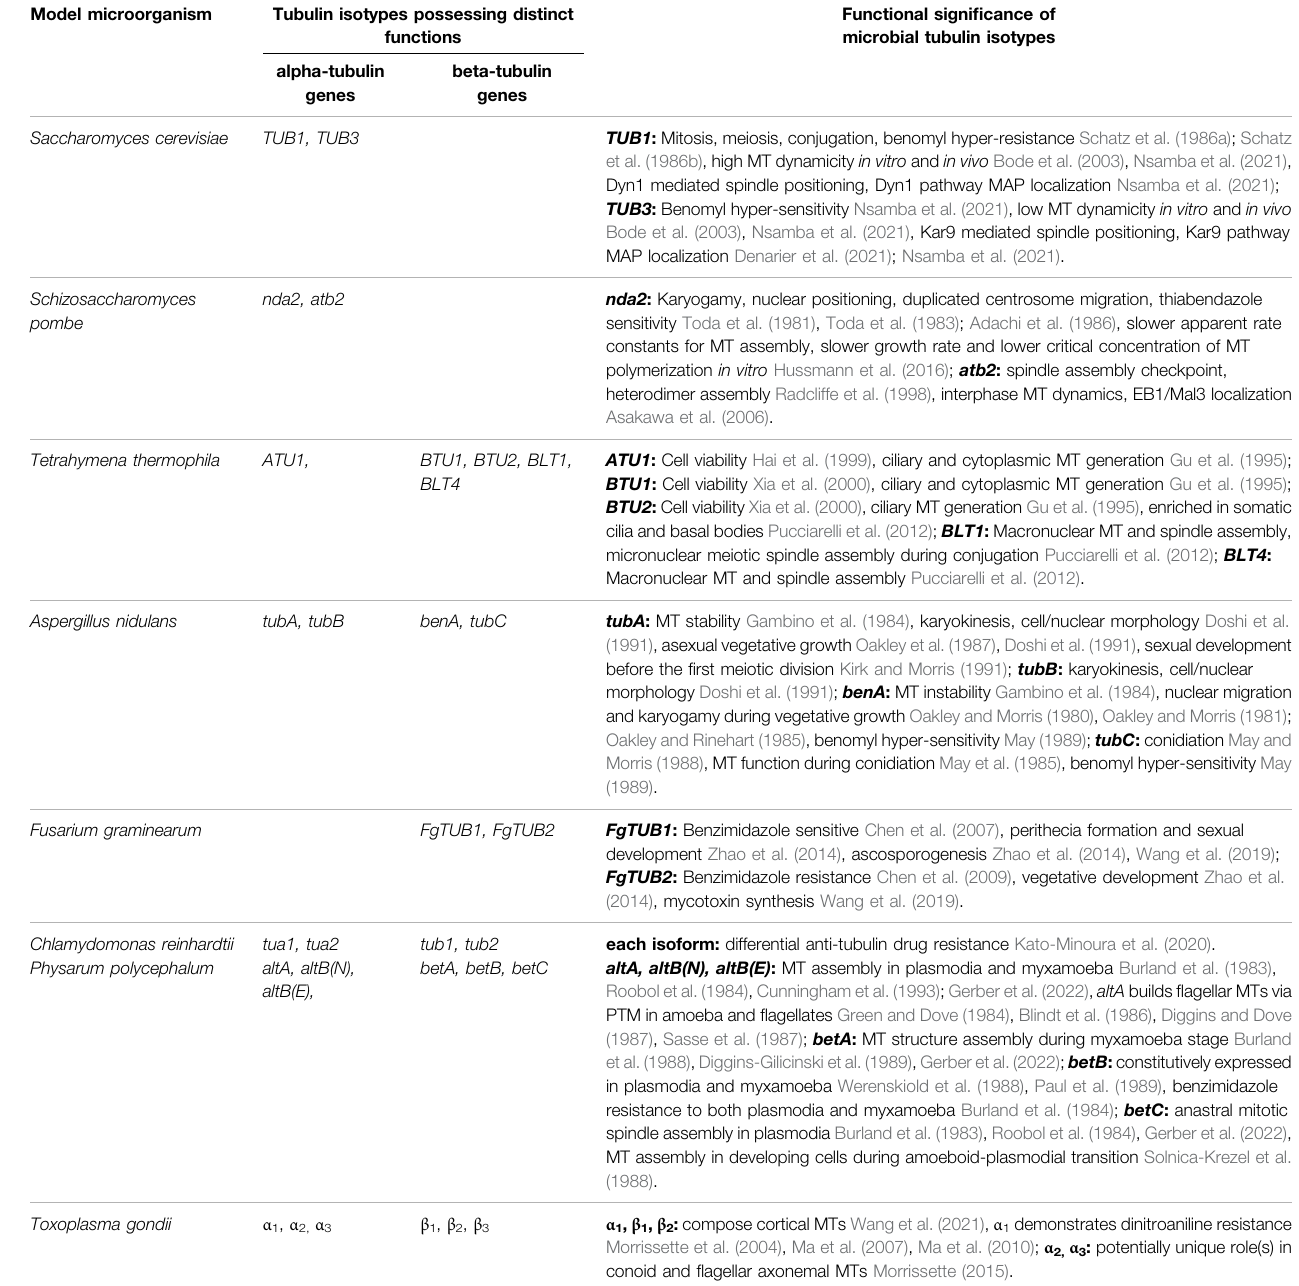
TABLE 2 | Microbial tubulin isotypes optimize and mediate differential organismal and cellular